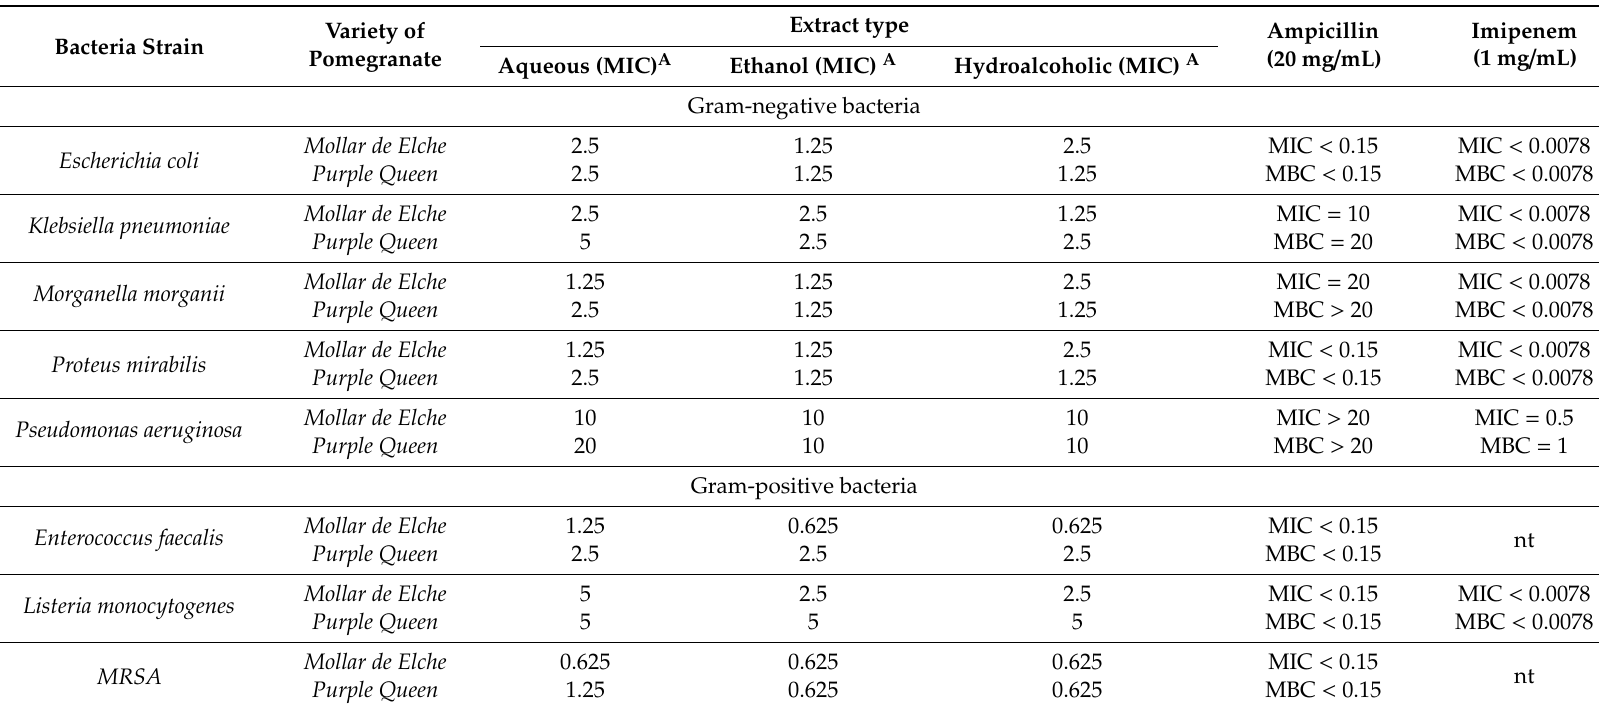
Table 4. Results of the antibacterial activity of di ff erent extracts of the pomegranate epicarp of the varieties Mollar de Elche and Purple Queen . Variety Bacteria Strain